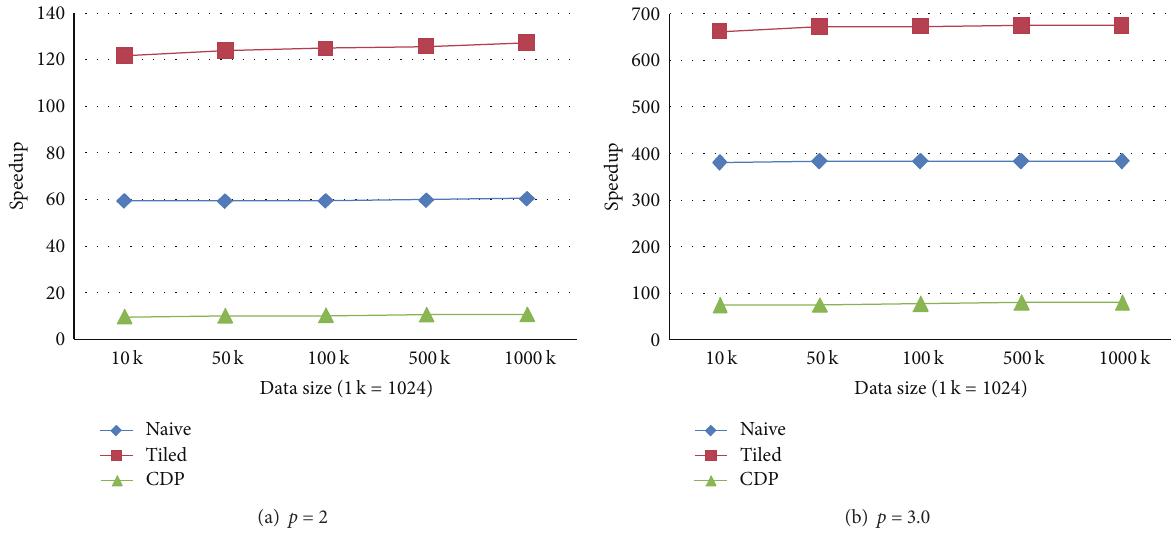
Figure 7: Speedups in the test case when the number of prediction points is fixed, and the number of data points differs. (a) The form in which the power parameter is set to 2. (b) The form in which the power parameter is set to 3.0.